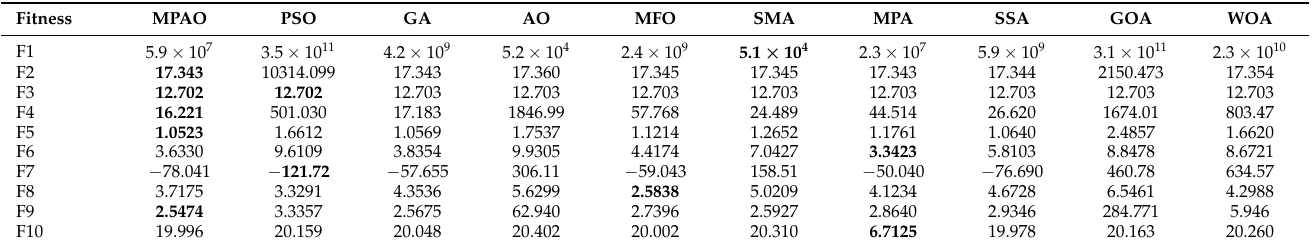
Table 4. Minimum values of the fitness